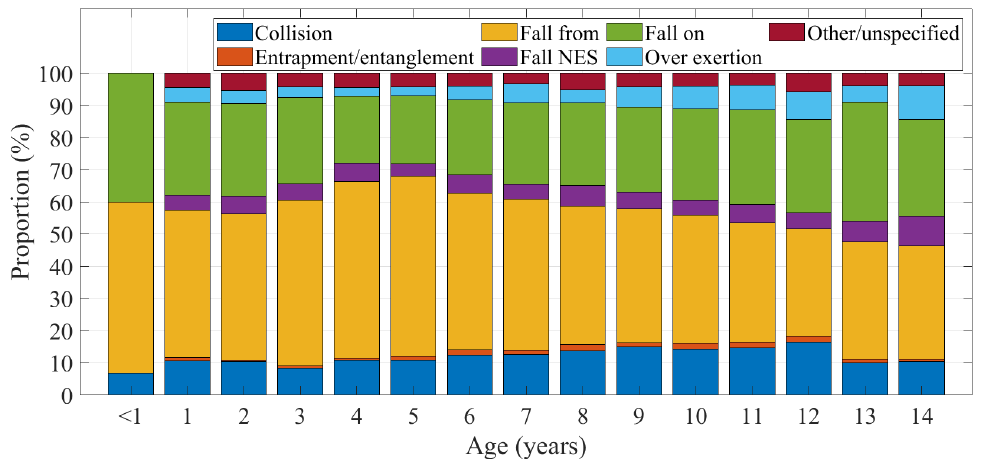
Figure 7. Injury mechanisms by